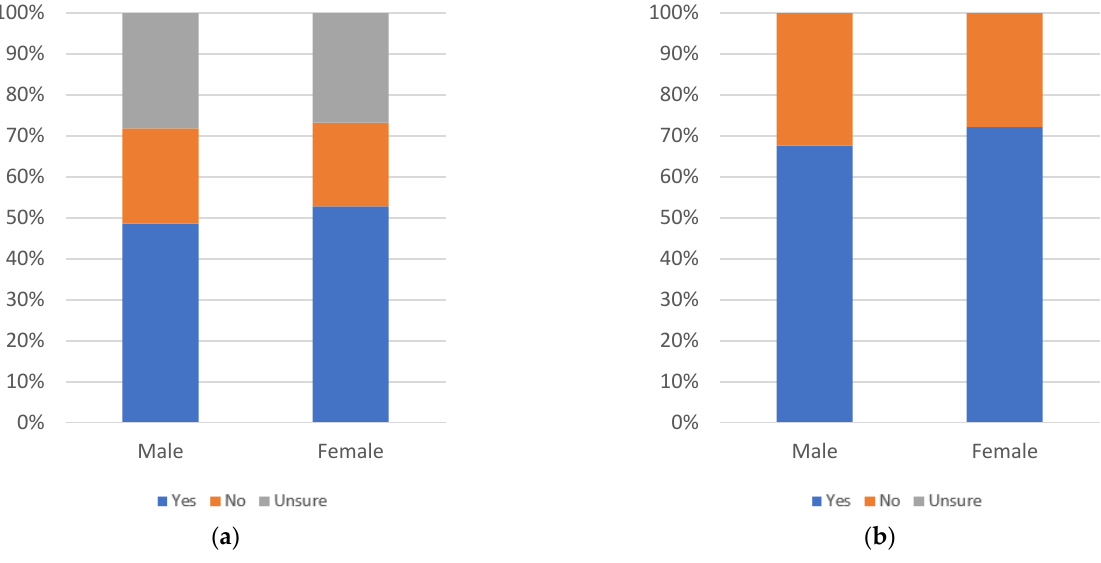
Figure 80. Label others’ use, by gender: ( a ) with uncertain respondents (left) and ( b ) without uncertain respondents (right).